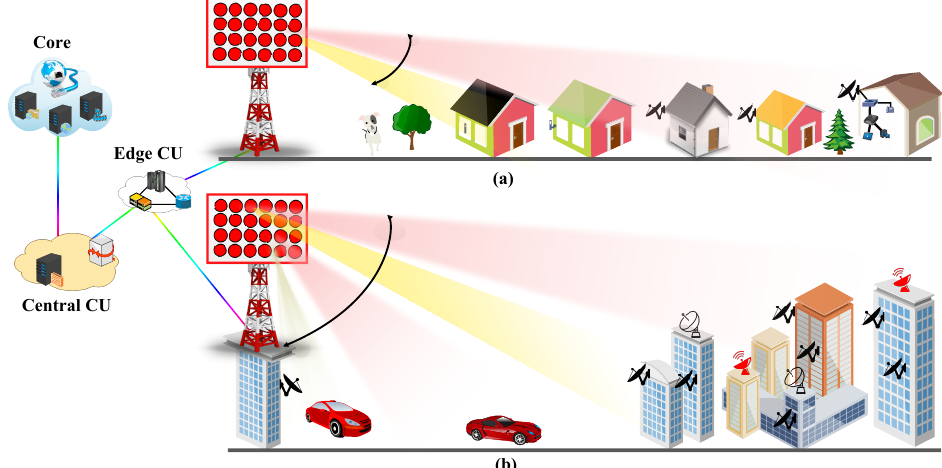
Figure 17. Scanning range for different deployment scenario ( a ) suburban and ( b ) dense urban landscapes (adapted from